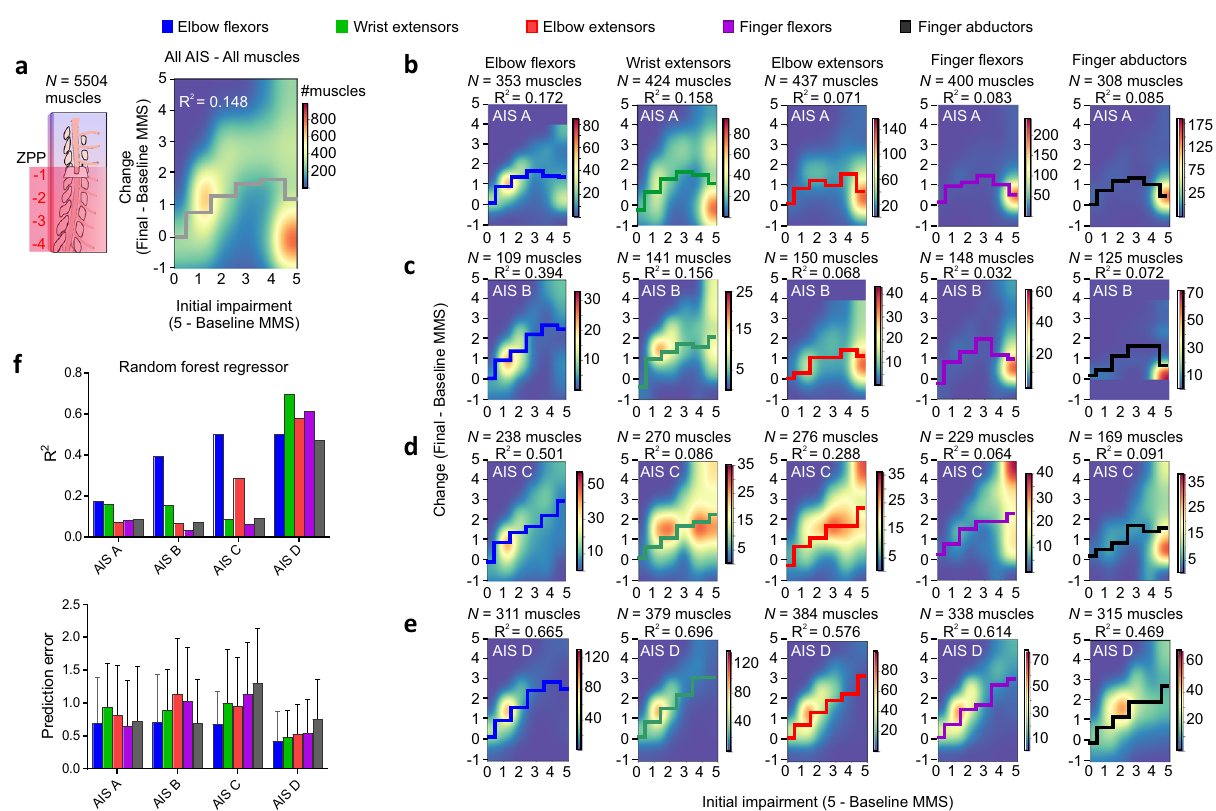
Fig. 4 | Prediction of strength recovery after cervical SCI: the role of baseline MMS. BaselineMMSisagoodpredictorofstrengthrecoveryat1-yearpost-SCIfor individuals with AIS D (high R 2 values) but is in most cases a poor predictor for those with an AIS A/B/C. a Considering all AIS and muscles, the prediction of strength recovery using baseline MMS is poor ( R 2 =0.148). b , c Individuals clas- si fi ed as AIS A or B show some degree of proportional recovery of upper limb muscles if the initial impairment is low, but strength recovery is constant or is inversely proportional if the initial impairment is high (especially for distal hand muscles). d In individuals classi fi ed as AIS C, proportional strength recovery is apparent for elbow fl exors, wrist extensors, elbow extensors, and fi nger fl exors. Proportionalrecoveryisalsoevidentfor fi ngerabductorsiftheinitialimpairment islowtomild(baselineMMSfrom3to5)butisconstantiftheinitialimpairmentis high (baseline MMS from 0 to 1). e Proportional strength recovery is evident for